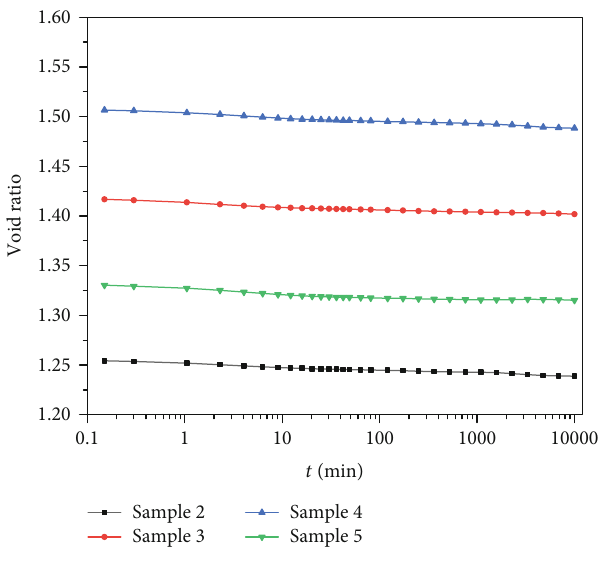
Figure 9: e − lg t curve of overconsolidated soil. Table 2: Creep coe ffi cient under di ff erent OCRs.